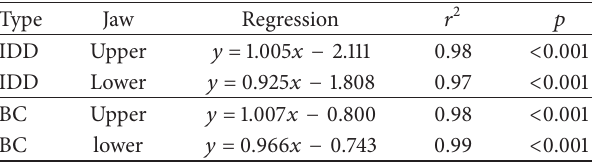
Table 1: Log-log regression between average interdental distance (IDD) or bite circumference (BC) and total body length of white sharks, Carcharodon carcharias , based on Lowry et al. (2009) [18]. Average interdental distance and bite circumference represent the dependent variables, whereas total length is the independent variable. 𝑟 2 = correlation coefficient; 𝑝 = significance